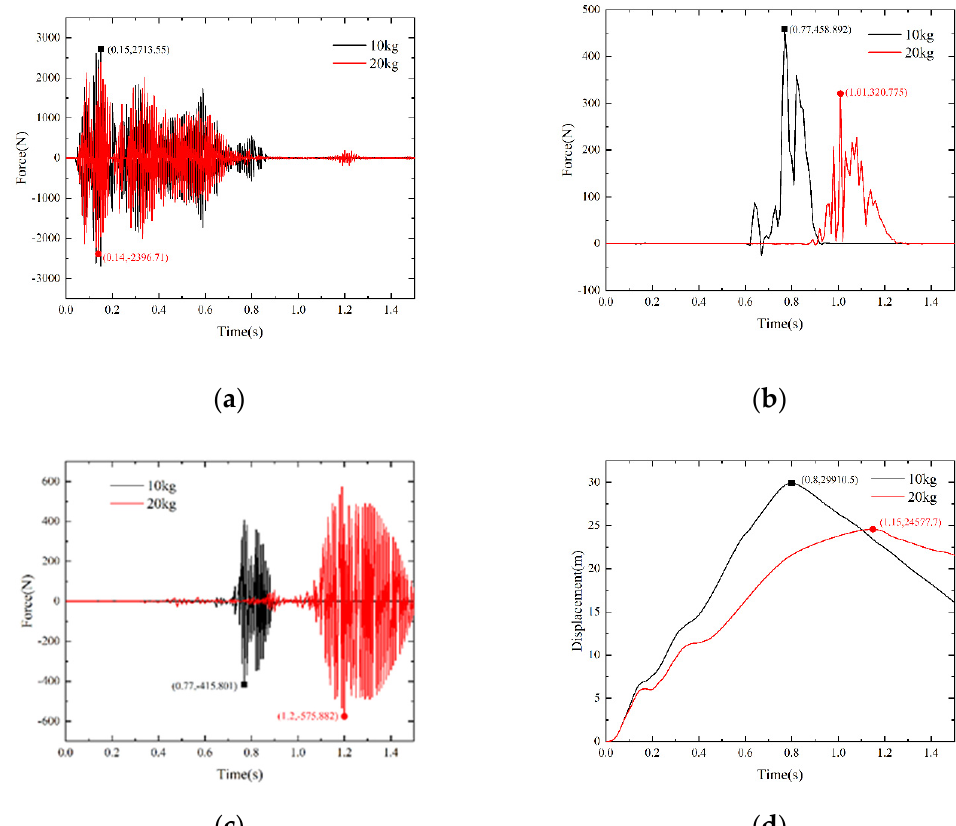
Figure 18. Deployment performance under different weight. ( a ) Extraction line force ( b ) Sling force ( c ) Suspension lines force ( d ) Tractor rocket displacement.